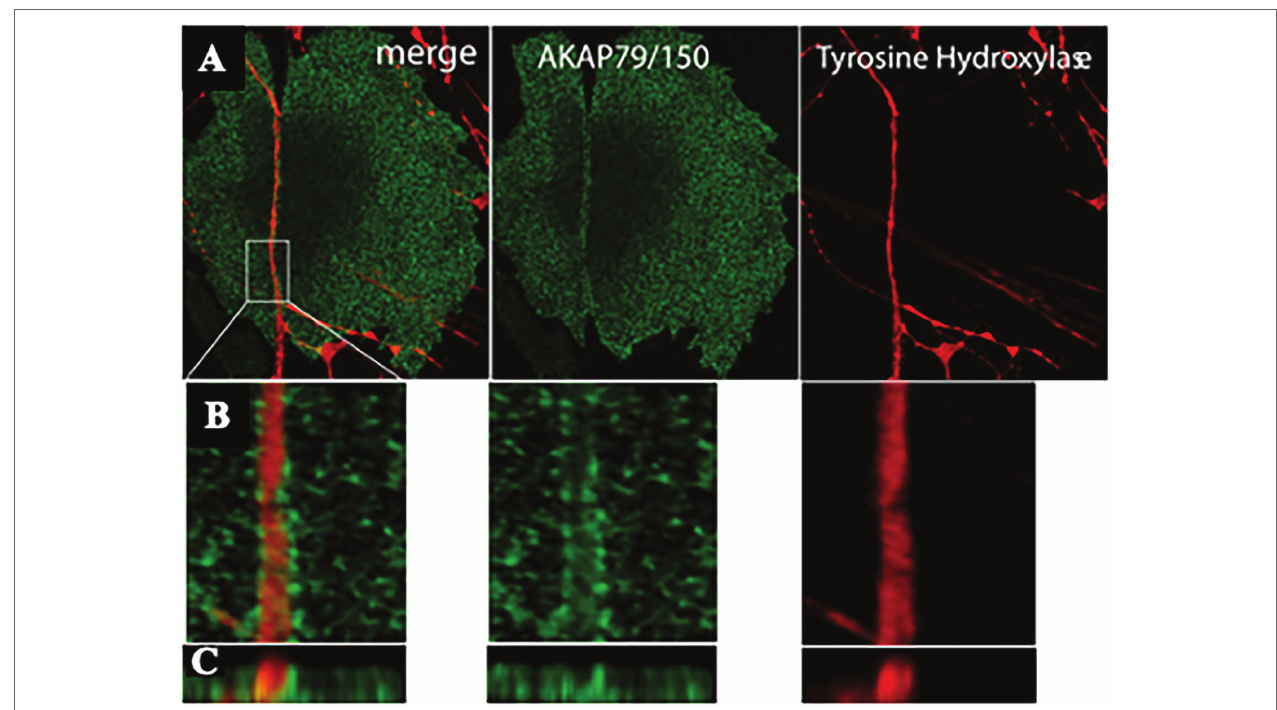
FIGURE 5 | AKAP79/150 accumulates at cardiac sympathetic synapses in vitro . (A) Colocalization of AKAP79/150 and tyrosine hydroxylase. CMs and SNs were cultured for 7 days and immunostained for tyrosine hydroxylase (red) and AKAP79/150 (green); two-photon image. (B) 3D-reconstructed enlarged fragment of the boxed area in (A) . (C) X-z cross section of the 3D reconstruction. Modified with permission from Shcherbakova et al.